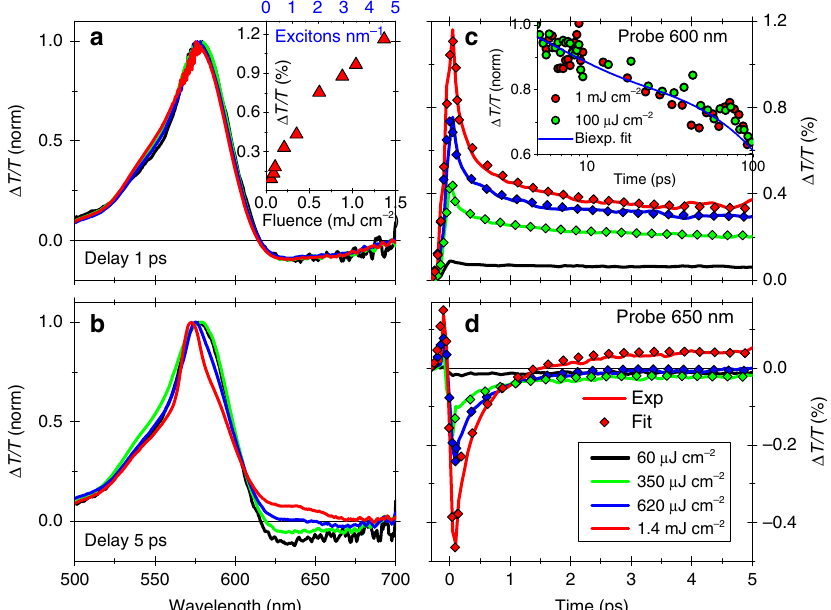
Figure 3 | Exciton–exciton annihilation and biexciton formation. Normalized D T / T spectra of 4CNRs for different excitation fluences at a fixed pump–probe delay of ( a ) 1ps and ( b ) 5ps. The inset in a reports the peak amplitude of the signal at 600nm probe wavelength as a function of the excitation fluence (bottom x axis) and the exciton linear density (top x axis). Excitation-fluence-dependent dynamics at ( c ) 600nm probe wavelength and ( d ) 650nm probe wavelength. The fit (diamonds) is obtained from the coupled rate-equations (described in the text) based on exciton–exciton annihilation in one dimension. Inset in c represents the dynamics on a 100ps timescale for 100 m Jcm (cid:2) 2 (low) and 1mJcm (cid:2) 2 (high) fluences, together with the bi-exponential fit used in Fig. 2b.